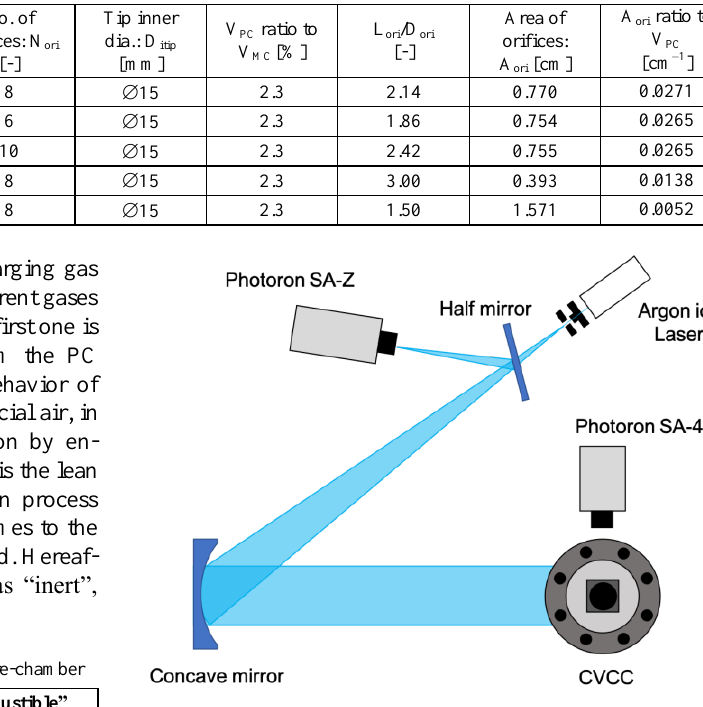
Fig. 4. Bird’s eye view of the shadowgraph optical setup